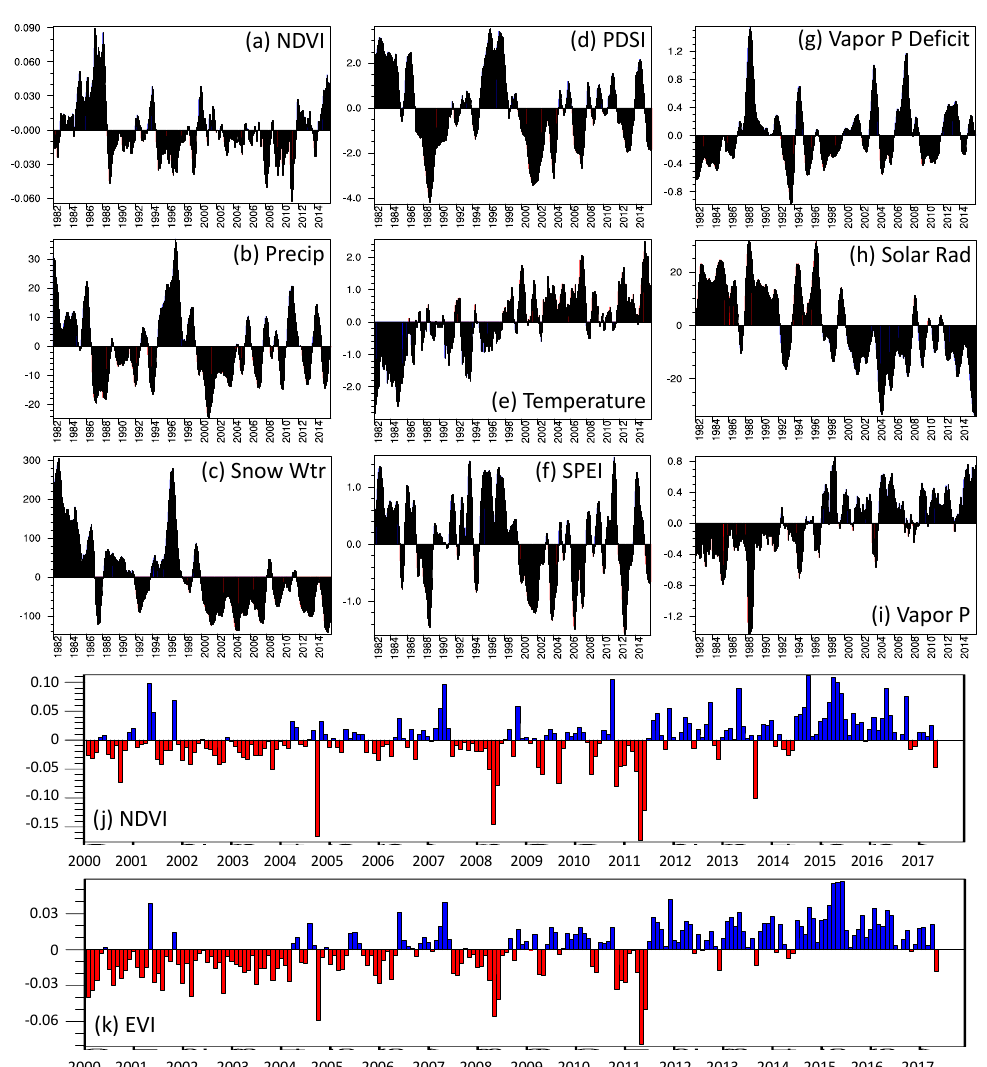
Figure 9. Time-series of monthly anomalies during 1982–2015 across Yellowstone National Park in the ( a ) Advanced Very High Resolution Radiometer (AVHRR) Normalized Difference Vegetation Index (NDVI), ( b ) Daymet precipitation (mm), ( c ) Daymet snow–water equivalent (kg m − 2 ), ( d ) Western Regional Climate Center (WRCC) PDSI, ( e ) Daymet air temperature ( ◦ C), ( f ) WRCC Standardized Precipitation Evapotranspiration Index (SPEI6mn), ( g ) Daymet vapor-pressure deficit (hPa), ( h ) Daymet incoming surface solar radiation (W m − 2 ), and ( i ) Daymet vapor pressure (hPa). A nine-point temporal smoother was applied to the time-series in ( a–i ). Time-series of monthly anomalies across the park during 2000–2017 in Moderate Resolution Imaging Spectroradiometer (MODIS)-based ( j ) NDVI and ( k ) Enhanced Vegetation Index